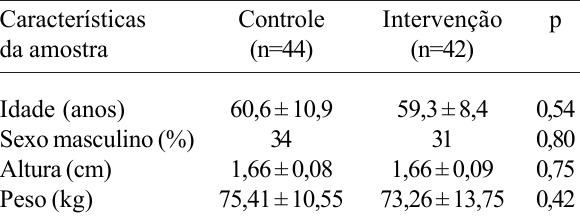
Tabela 1. Comparação dos grupos